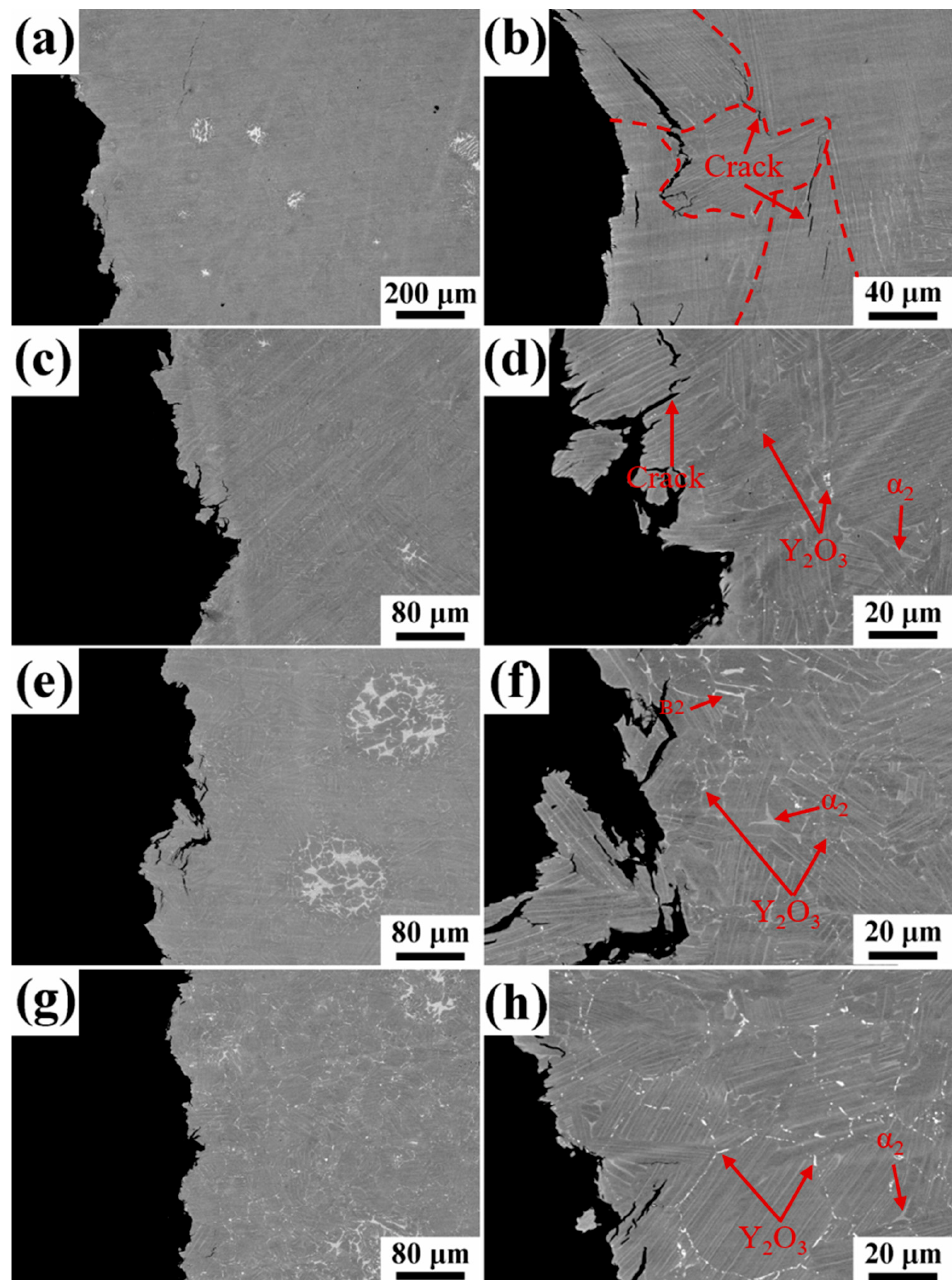
Figure 7. Fracture side face after tensile test at 800 °C: ( a , b ) 0 at%; ( c , d ) 0.05 at%; ( e , f ) 0.10 at%; ( g , h ) 0.20 at%.